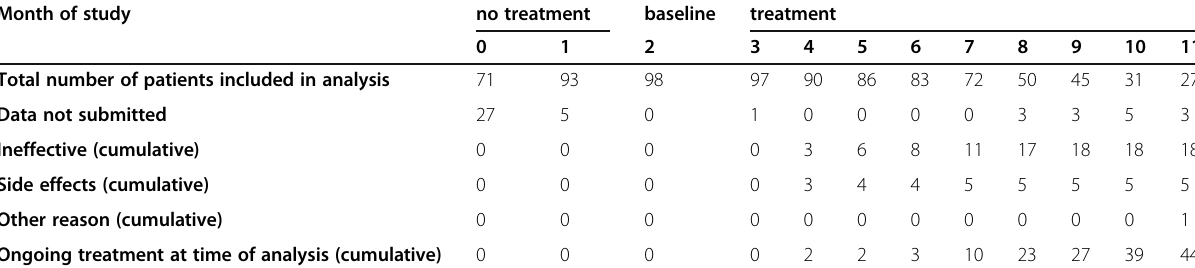
Ongoing treatment at time of analysis (cumulative)